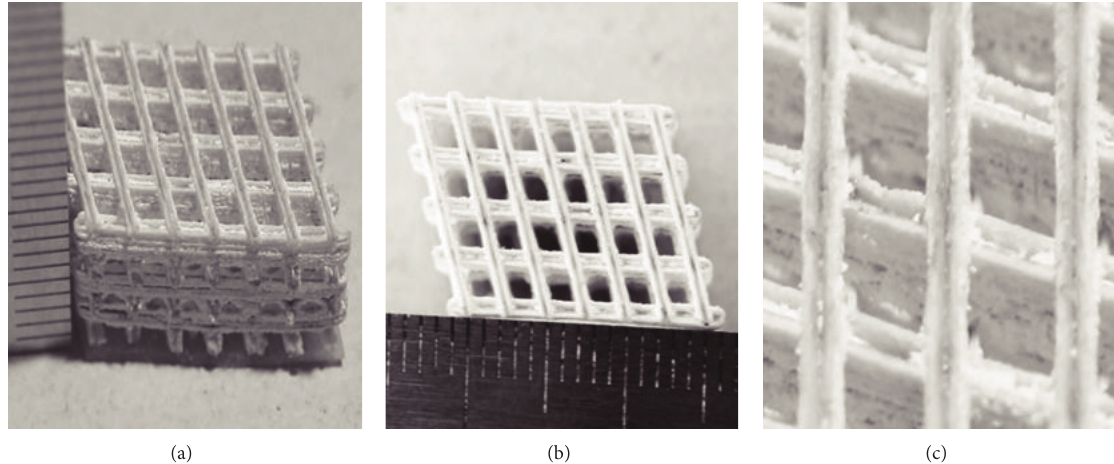
Figure 5: The interconnected porous scaffold fabricated by SLS: (a) isometric view; (b) top view; (c) magnifying view.